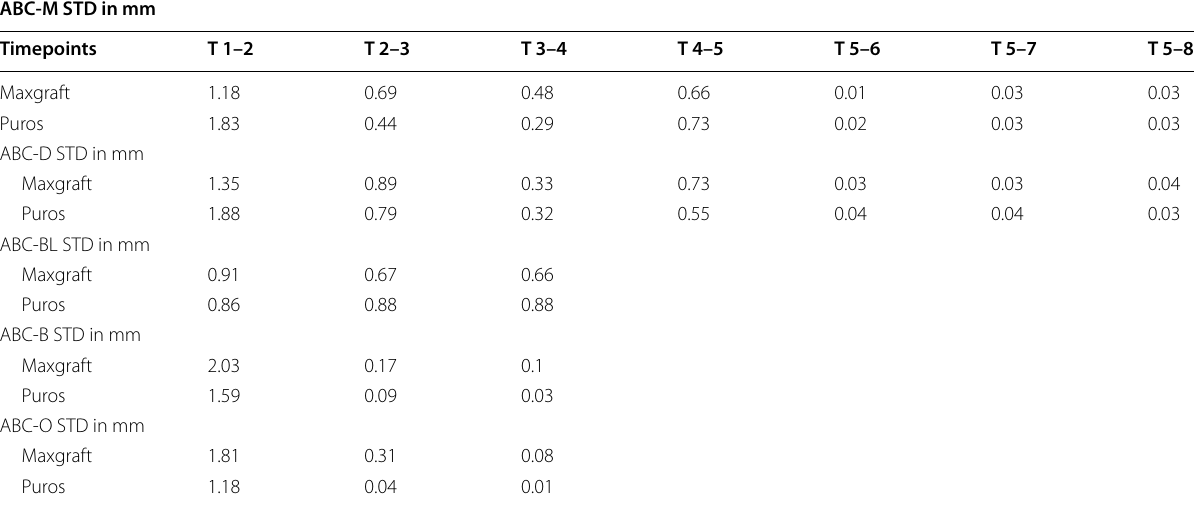
Table 3 Shows the standard deviation (mm) of changes from the mesial (ABC-M) and distal (ABC-D) alveolar bone crest to the cemento-enamel junction (CEJ) or restorative margin (RM) between the different time points at T1–T2, T2–T3, T3–T4, T5–T6, at 1